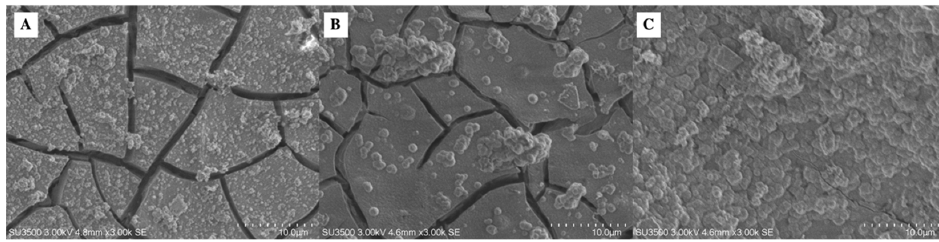
Figure 7. The SEM images of different samples after seven days of SBF immersion ( A ) Native AZ31B; ( B ) AZ31B/TA; and ( C ) AZ31B/TA/HYA.